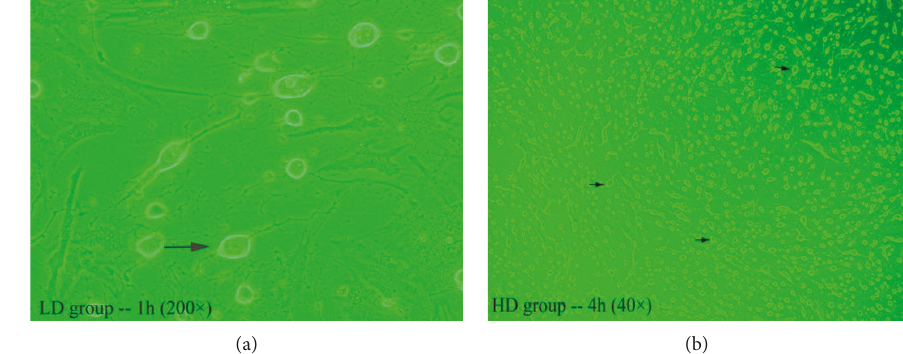
Figure 3: (a) (200x) Arrowheads show neuron-like cells. (b) (40x) A large number of neuron-like cells, arrowheads show neuron-like